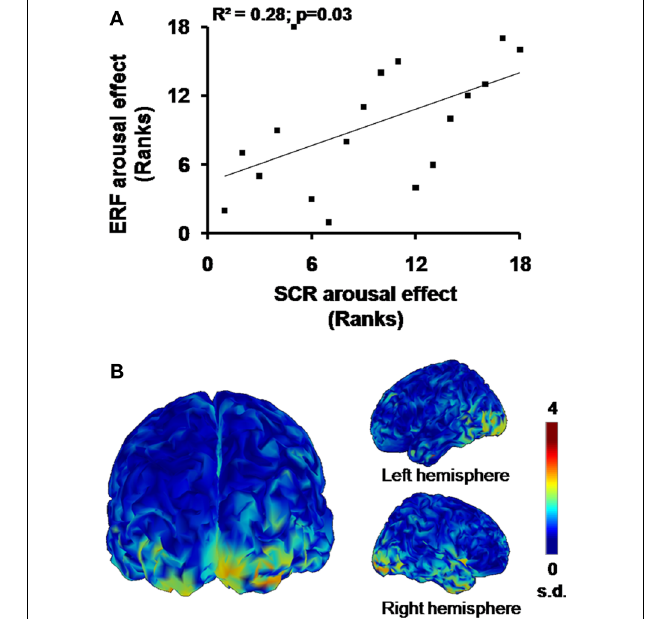
FIGURE 6 | Emotional arousal effects. (A) Signifi cant rank correlation for arousal effects between SCR and ERF. (B) Cortical maps of the grand average ( n = 18) of normalized current dipole densities over the bilateral occipitotemporal